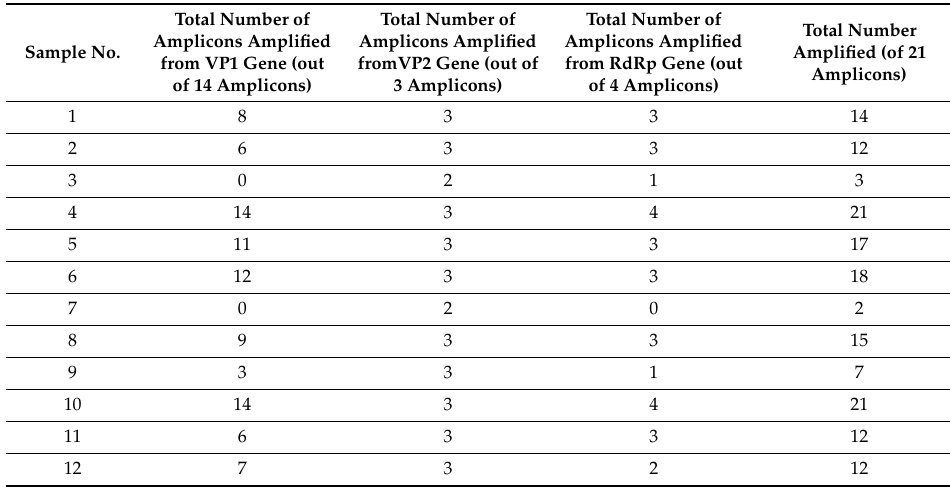
Table 5. A summary of each sample with the corresponding number of total positive amplification results for each segment of the TSV genome and the total number of positive amplification results per